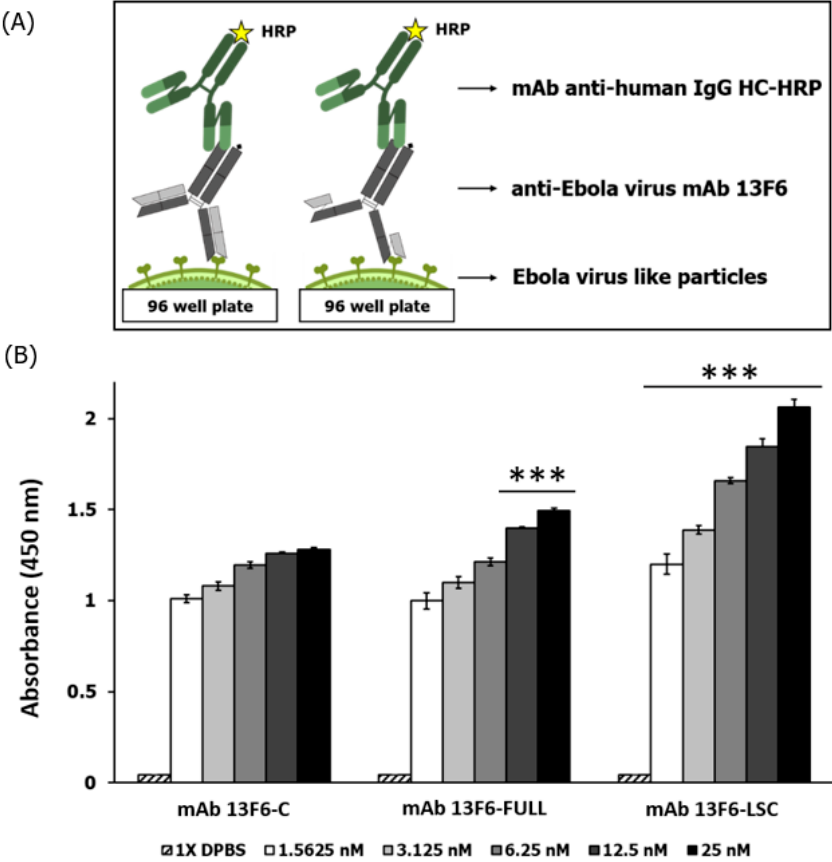
Figure 7. ELISA method to measure the binding affinity of mAb 13F6-FULL, and mAb 13F6-LSC to Ebola VLP. ( A ) Schematic diagram of an ELISA plate with mAb 13F6-FULL, and mAb 13F6-LSC to Ebola VLP. ( B ) Measurement of the binding activity of mAb 13F6-FULL and mAb 13F6-LSC to the Ebola VLP by indirect ELISA. The VLP (1 μ g/well) was coated on the 96-well MaxiSorp immune plate. The primary antibodies were the mAb 13F6-C, mAb 13F6-FULL, and the mAb 13F6-LSC; the